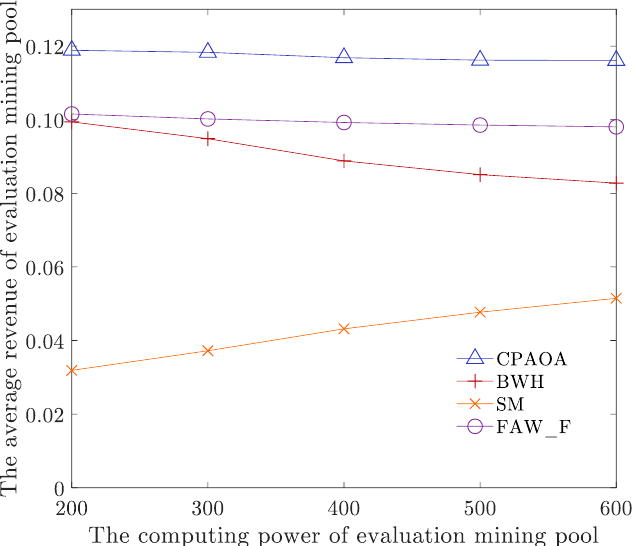
Figure 8. Comparison of the average revenue of algorithms with computing power of an evaluation mining pool.